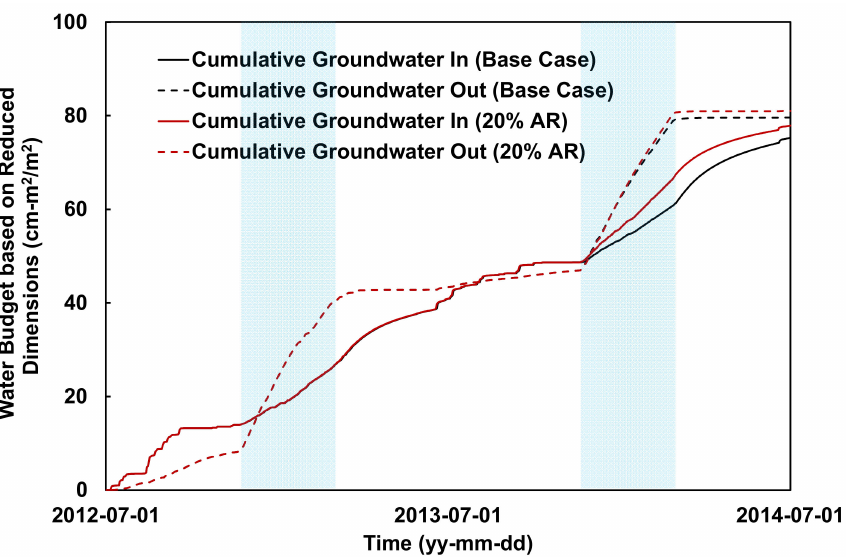
Figure 9. Cumulated water budget of the aquifer storage model from September 2012 to June 2014 (blue boxes represent WCC